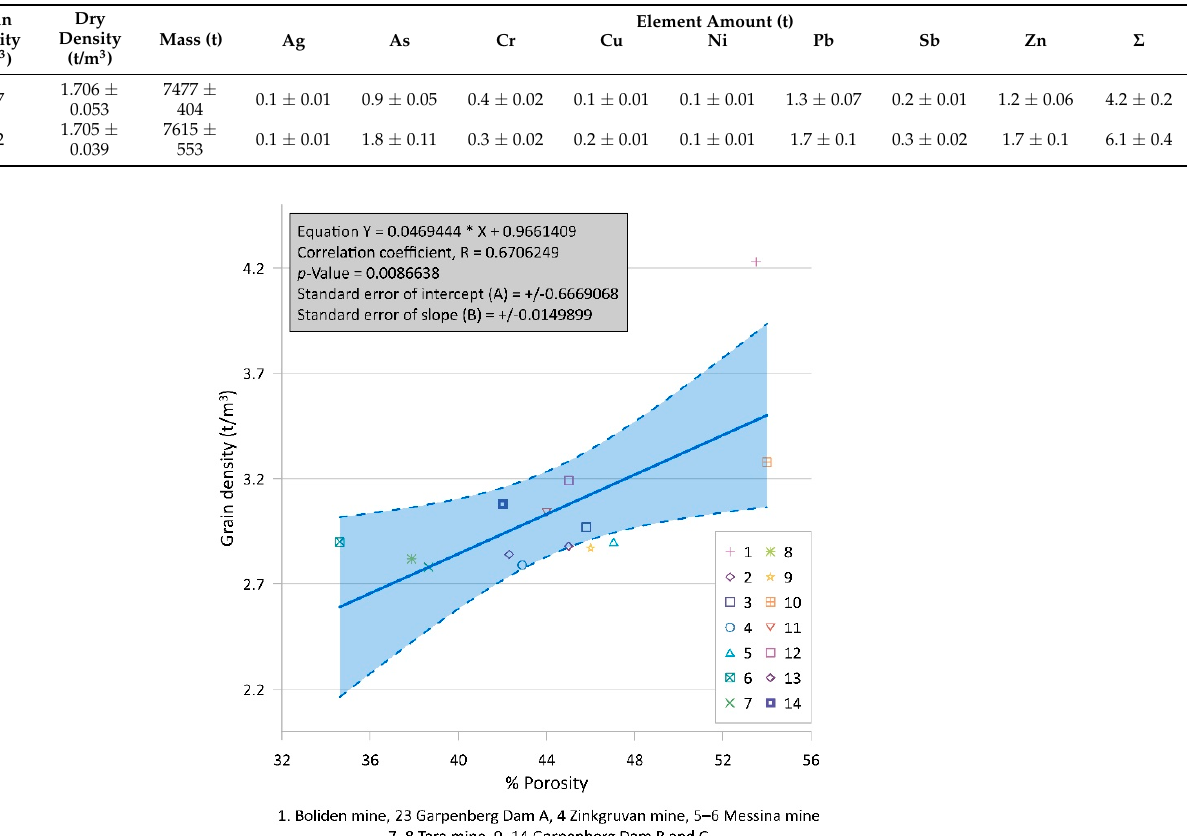
Table 5. Main physical features of the mine tailings and amounts of metals eroded.